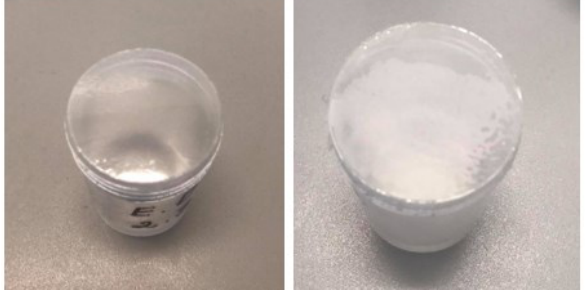
Figure 13. Water vapor transmission rate (WVTR) test. Films before (left) and after